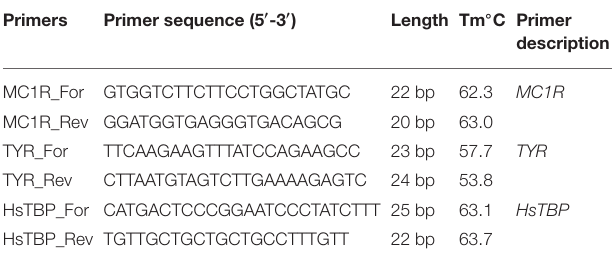
TABLE 1 | Primers used in this